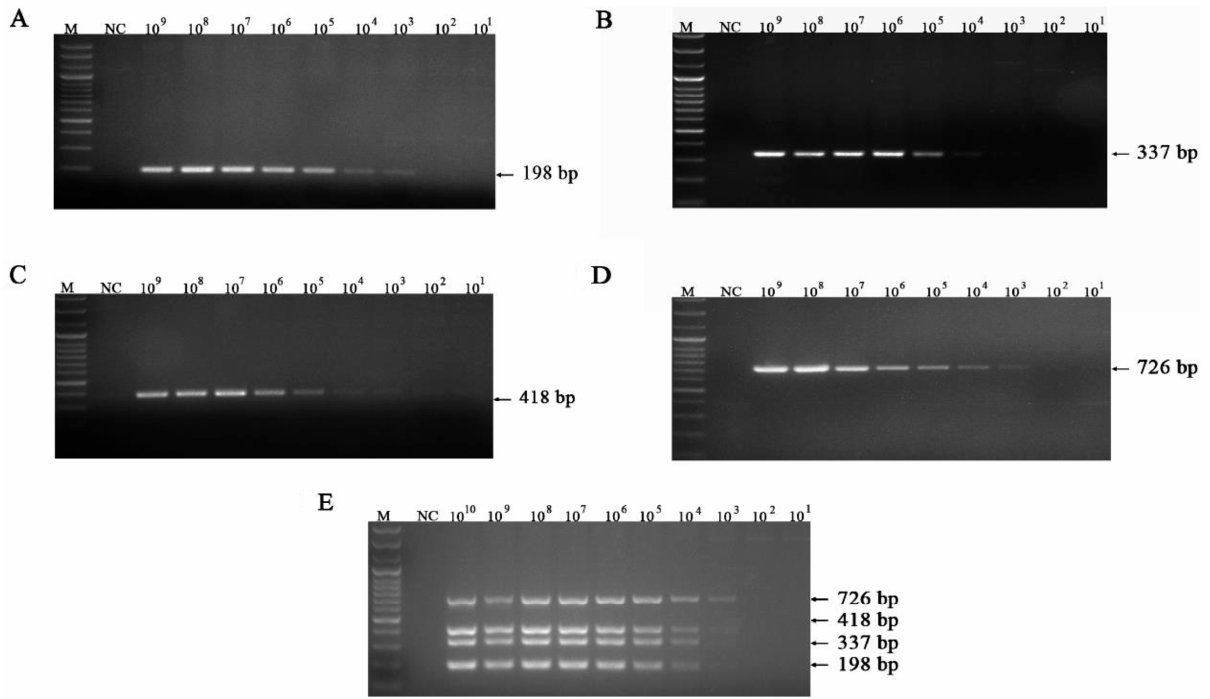
Figure 3. Sensitivity for FeKoV, FPV, FeAstV, and FCoV. ( A ) Sensitivity for FeKoV; ( B ) sensitivity for FPV; ( C ) sensitivity for FeAstV; ( D ) sensitivity for FCoV; ( E ) sensitivity for FeKoV/FPV/FeAstV/FCoV; lane M, DNA marker (100 bp ladder plus); lane NC, negative control.